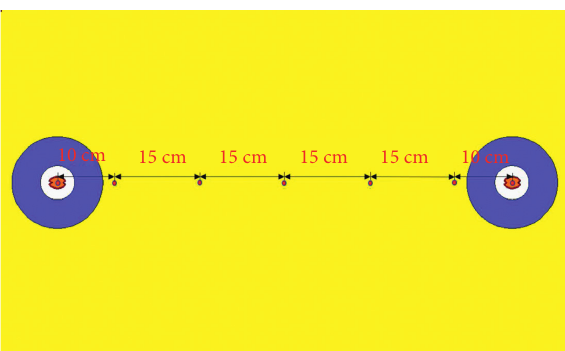
Figure 16: Key points location on double-hole loading.